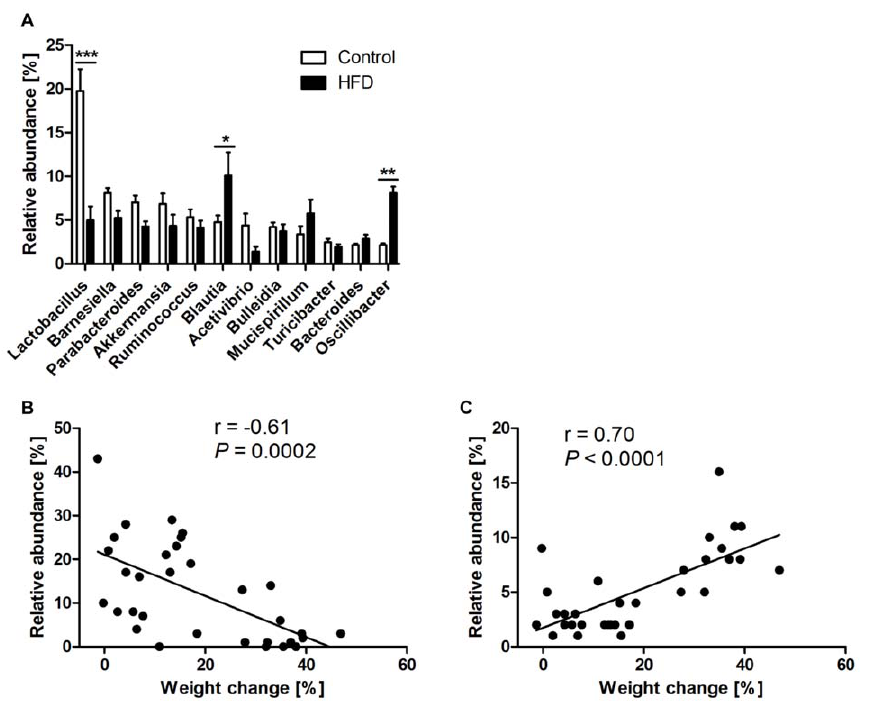
Figure 4. Gut microbiota composition in control and high saturated fat diet (HFD) fed mice. A: Relative abundance of main genera in fecal samples from control (open bars) and HFD (closed bars) mice (n=16 per group). Data are shown as mean 6 SEM. *** P , 0.001, ** P , 0.01 and * P , 0.05 compared to control. Correlations between the abundance of Lactobacillus (B) and Oscillibacter (C) and weight changes. Gut microbiota profile was determined by metagenomic pyrosequencing from bacterial lineages in fecal samples.